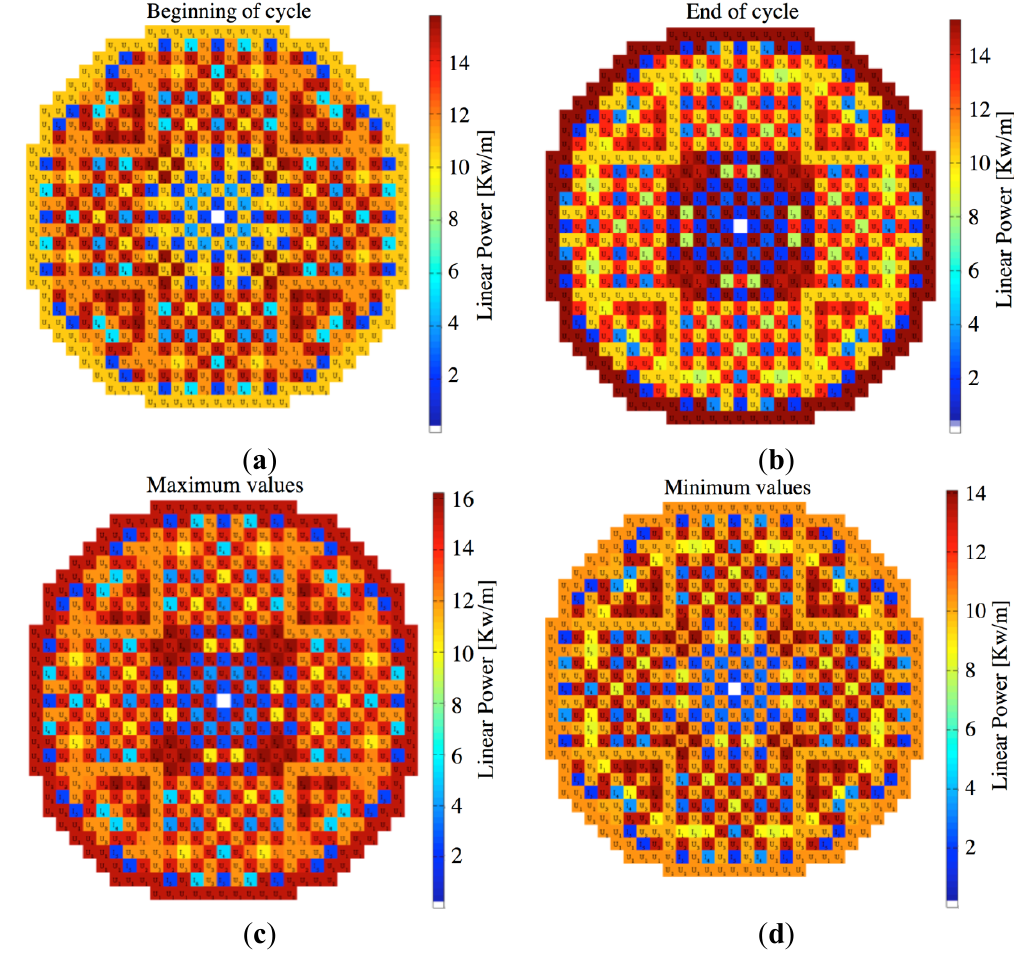
Figure 9. Radial core power profile. The power distribution within the core assemblies is shown for the ( a ) end of campaign; ( b ) beginning of campaign; ( c ) minimum values and ( d ) maximum